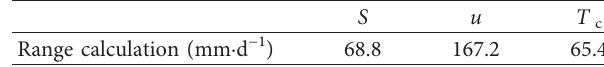
Table 4: Calculation of variance of v